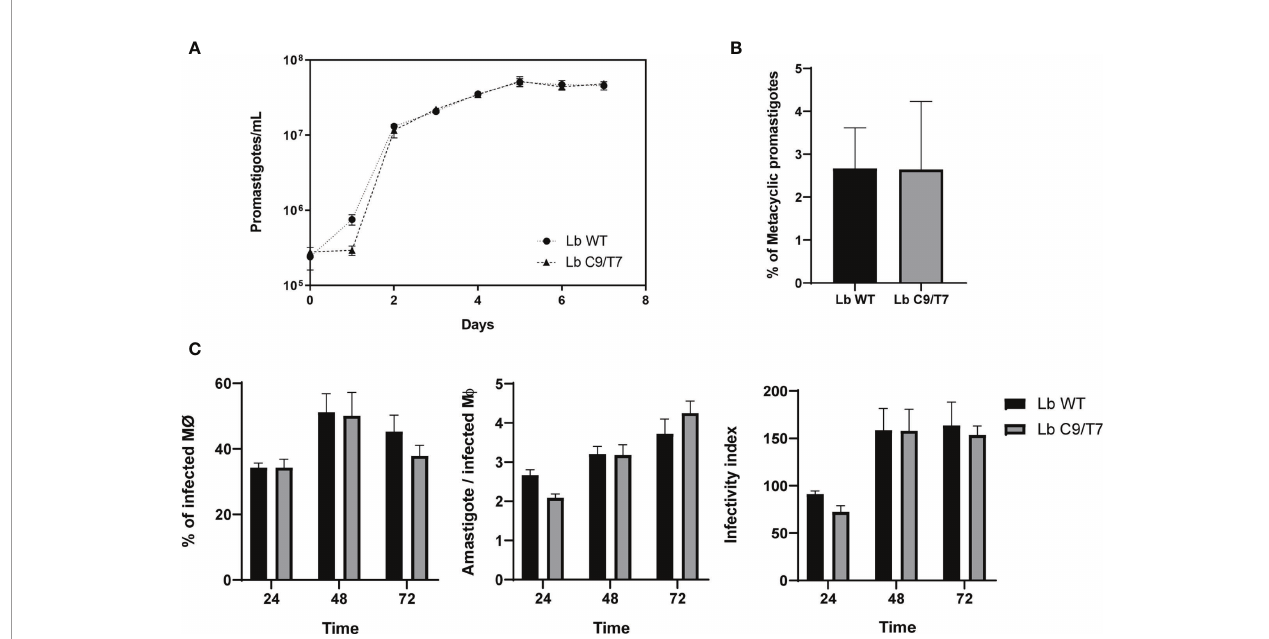
FIGURE 3 | Phenotypic characterization of Lb C9/T7 and Lb WT growth in culture, metacyclogenesis, and infectivity in THP-1 cell lines. (A) Parasite density was adjusted to 2 · 10 5 promastigotes/ml and followed up in three biological replicates during 7 days. No signi fi cant difference in parasite growth in culture was observed when Lb C9/T7 and Lb WT area under the curves were compared ( t -test; p < 0.05). (B) Culture density was adjusted to 2 · 10 5 promastigotes/ml. After 7 days, parasites were counted in biological triplicates before and after Ficoll enrichment to determine the percentage of metacyclics in Lb WT and Lb C9/T7, and no signi fi cant differences were observed ( t -test; p < 0.05). (C) Infectivity of Lb C9/T7 and Lb WT to THP-1-differentiated macrophages was compared after 24, 48, and 72 h. THP-1 cells were infected with Ficoll-puri fi ed metacyclic promastigotes at the MOI of 10:1 (metacyclics:cell) during 4 h at 37°C 5% CO 2 . Infections progressed during the selected time points, and the percentage of infected macrophages, the number of amastigotes per macrophage, and the infectivity index were determined by counting 100 Giemsa-stained cells per slide. The graphs are representative of two independent experiments performed in technical triplicates, and no signi fi cant difference between Lb WT and Lb Cas9/T7 was observed ( t -test; p <